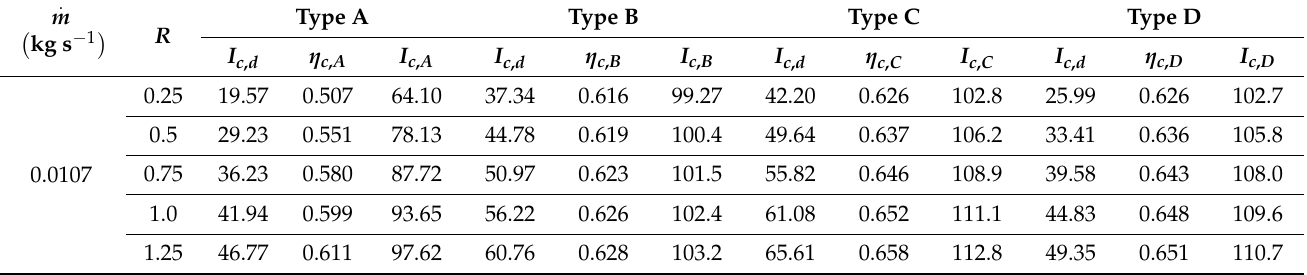
Table 4. Effects of external-recycle types on collector efficiency improvements. ( α = 0.5, β = 0.5 and I 0 = 830 W m − 2